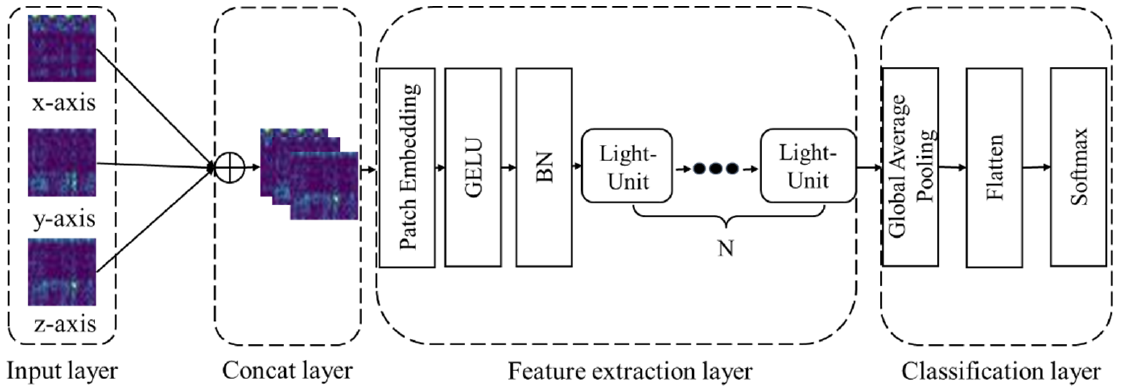
Figure 7. Overall structure of the proposed MCDS-CNN. Table 1. Specific parameters of the proposed MCDS-CNN.